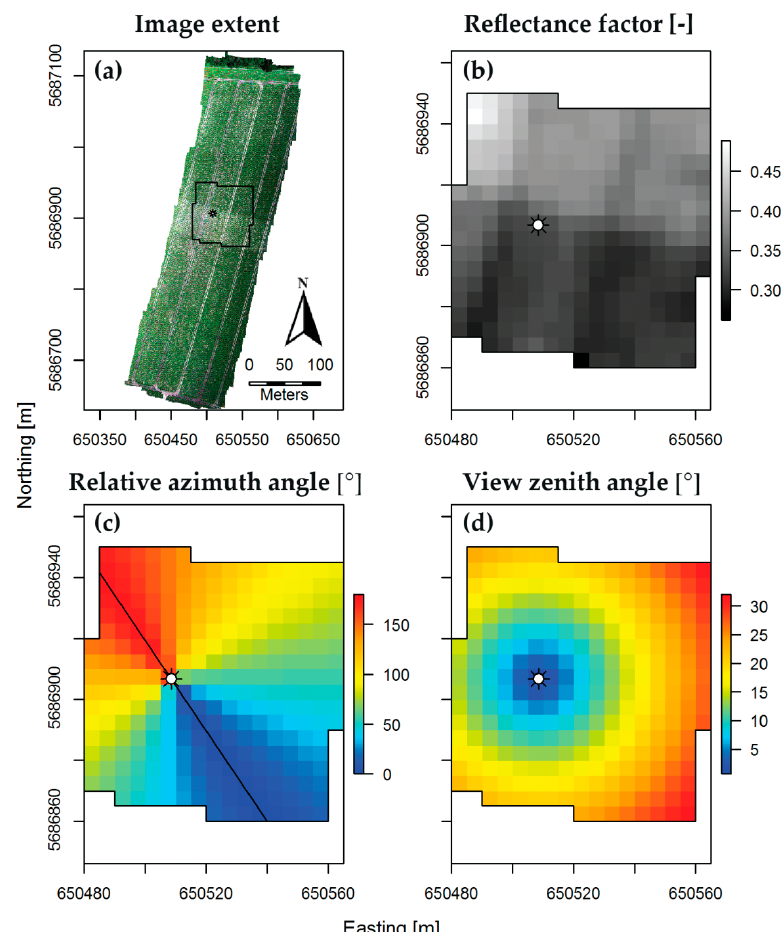
Figure 2. An example of the observation geometry of the pixels of one of the georeferenced images. ( a ) An RGB composite (R = 674 nm, G = 559 nm, and B = 500 nm) of the study area, collected on 9 June 2016, showing the location of the current image (black line) and the position of the unmanned aerial vehicle (UAV) (sun-shaped symbol); ( b ) the reflectance factors at 864 nm of the current image; ( c ) the relative azimuth angles of the pixels of the current image, where 0° is the forward scattering direction and 180° is the backward scattering direction. The solar principal plane is indicated by the black line; ( d ) the view zenith angle of the pixels of the current image. Projection of ( a – d ) is WGS84 UTM 31N.